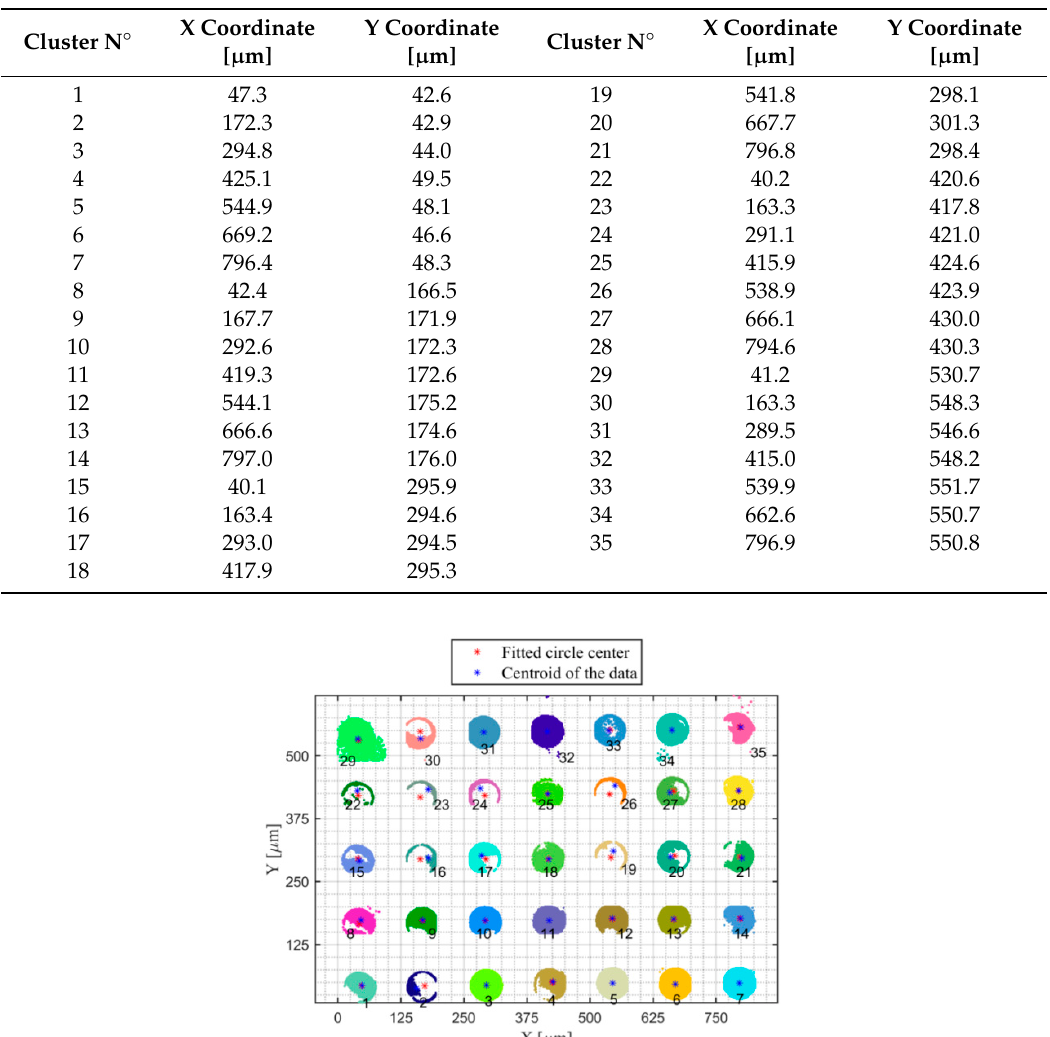
Table 4. The raw coordinate values of the fitted cylinder centers.